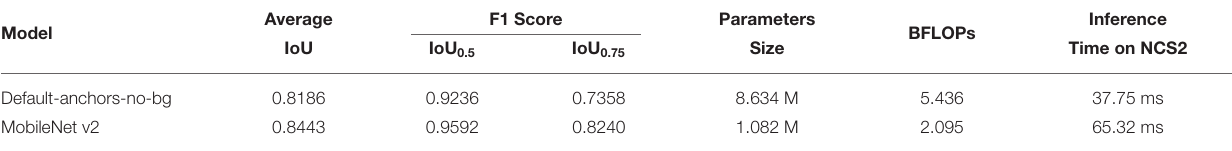
TABLE 6 | Performance data of MobileNet v2.